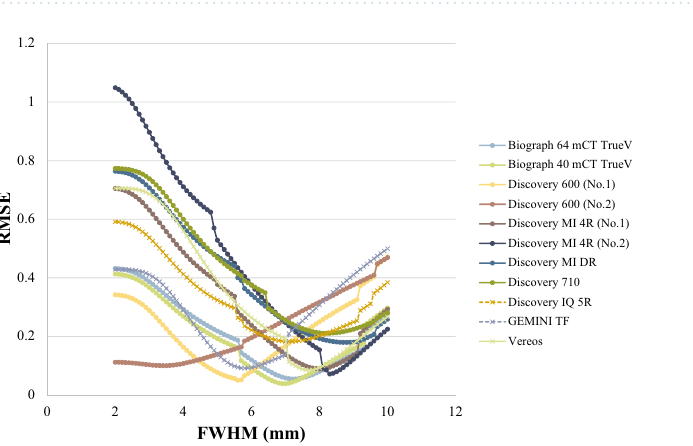
Figure 3. VOI placement for SUV validation using RAVAT.